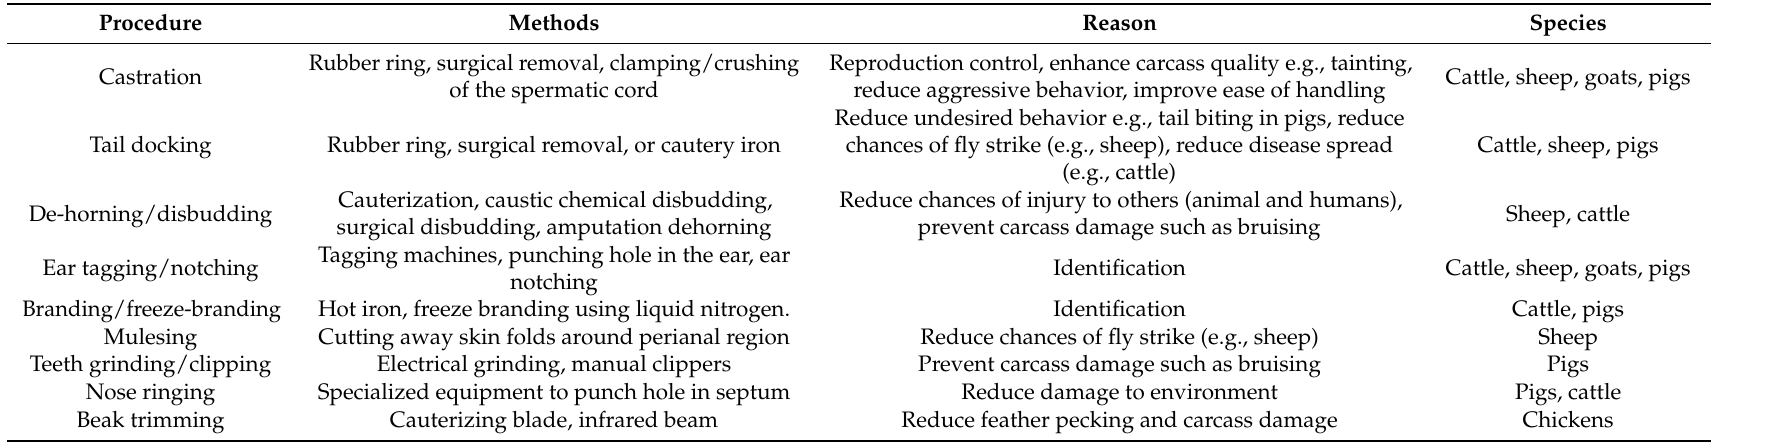
Table 1. Routine husbandry practices carried out on farm animals and their